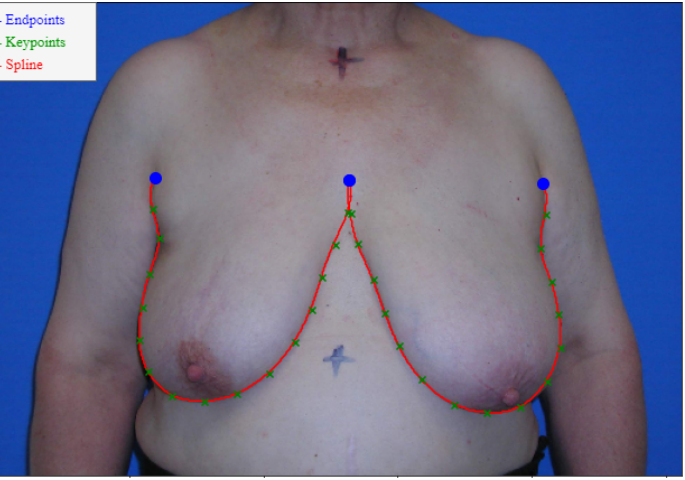
Figure 6. Breast Keypoints (green), Endpoints (blue) and Paths (red) notation